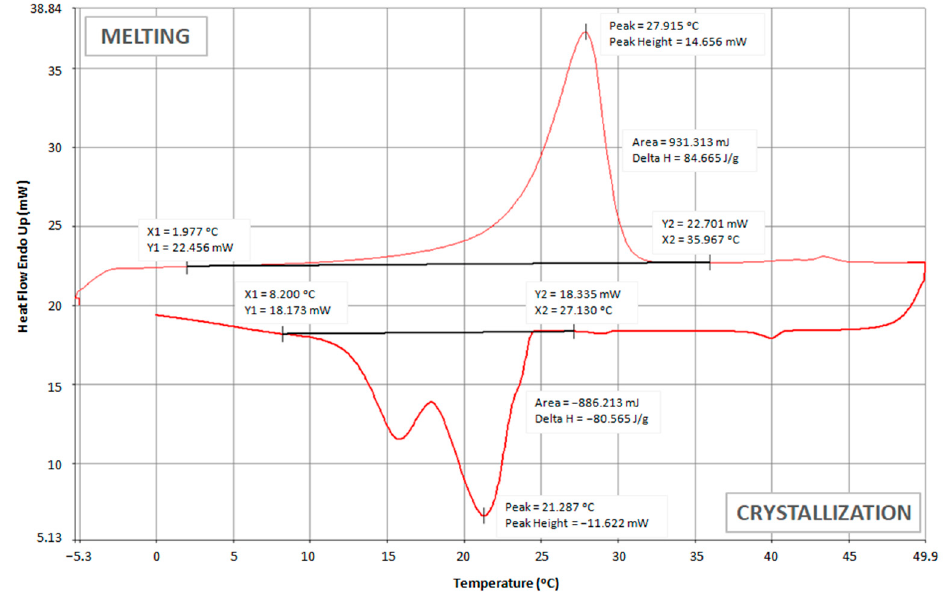
Figure 7. DCS thermogram of PES + PCM2_15 insert.